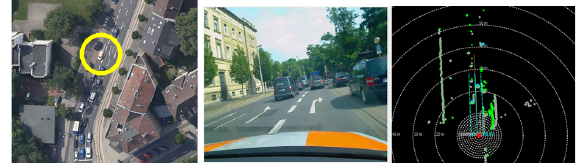
Figure 1. Different views at the same time